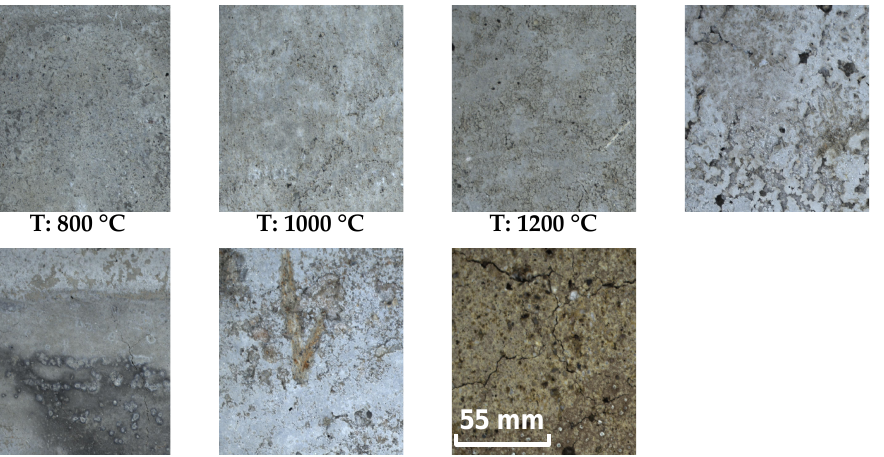
Figure 8. Comparision of different color and texture of concrete specimens from 20 to 1200 °C. The presented features were extracted from both IE signals and images of test speci- mens. To process this data, we used a desktop PC with an Intel i5-10600 3.3 GHz processor, NVIDIA Quadro RTX 4000, 64 GB 2666 MHz DD4 RAM. The average time of feature extraction of signal parameters was 0.05 s, and the average time of image features